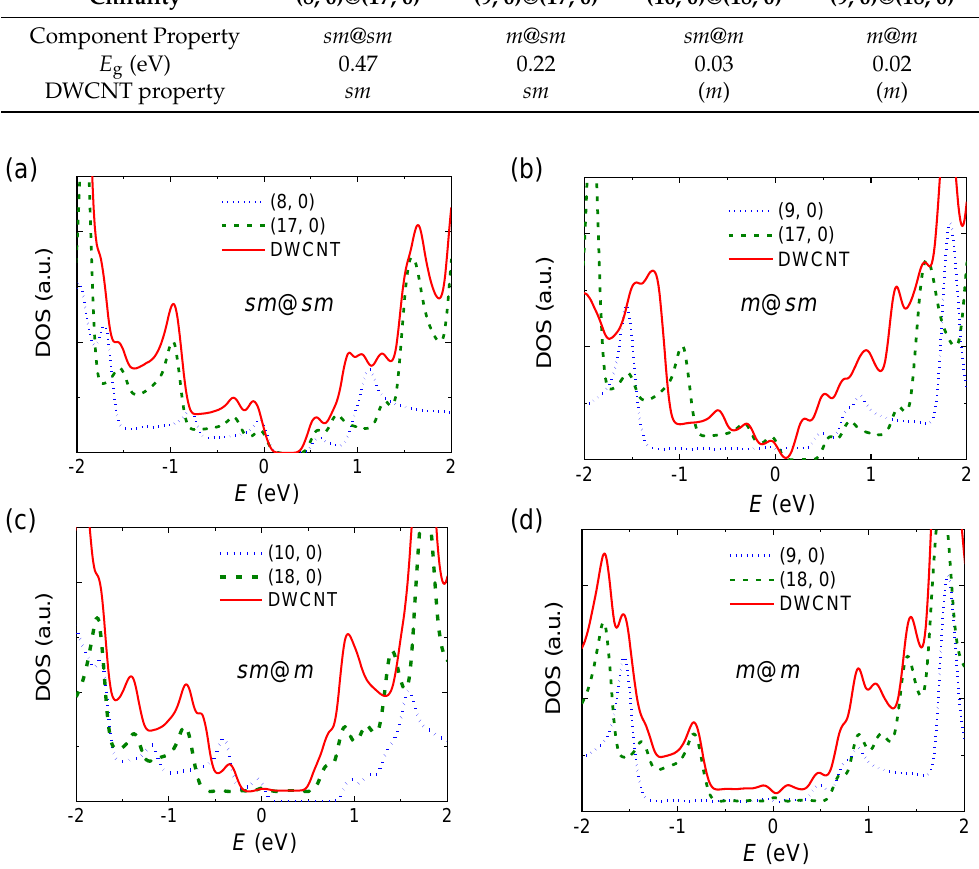
Figure 4. Electronic DOS of DWCNTs, sm @ sm ( a ), m @ sm ( b ), sm @ m ( c ) and m @ m ( d ), which also show the DOS of SWCNTs constructing DWCNTs. Gaussian broadening with 0.05 eV width has been applied to the eigenvalues obtained from DFT